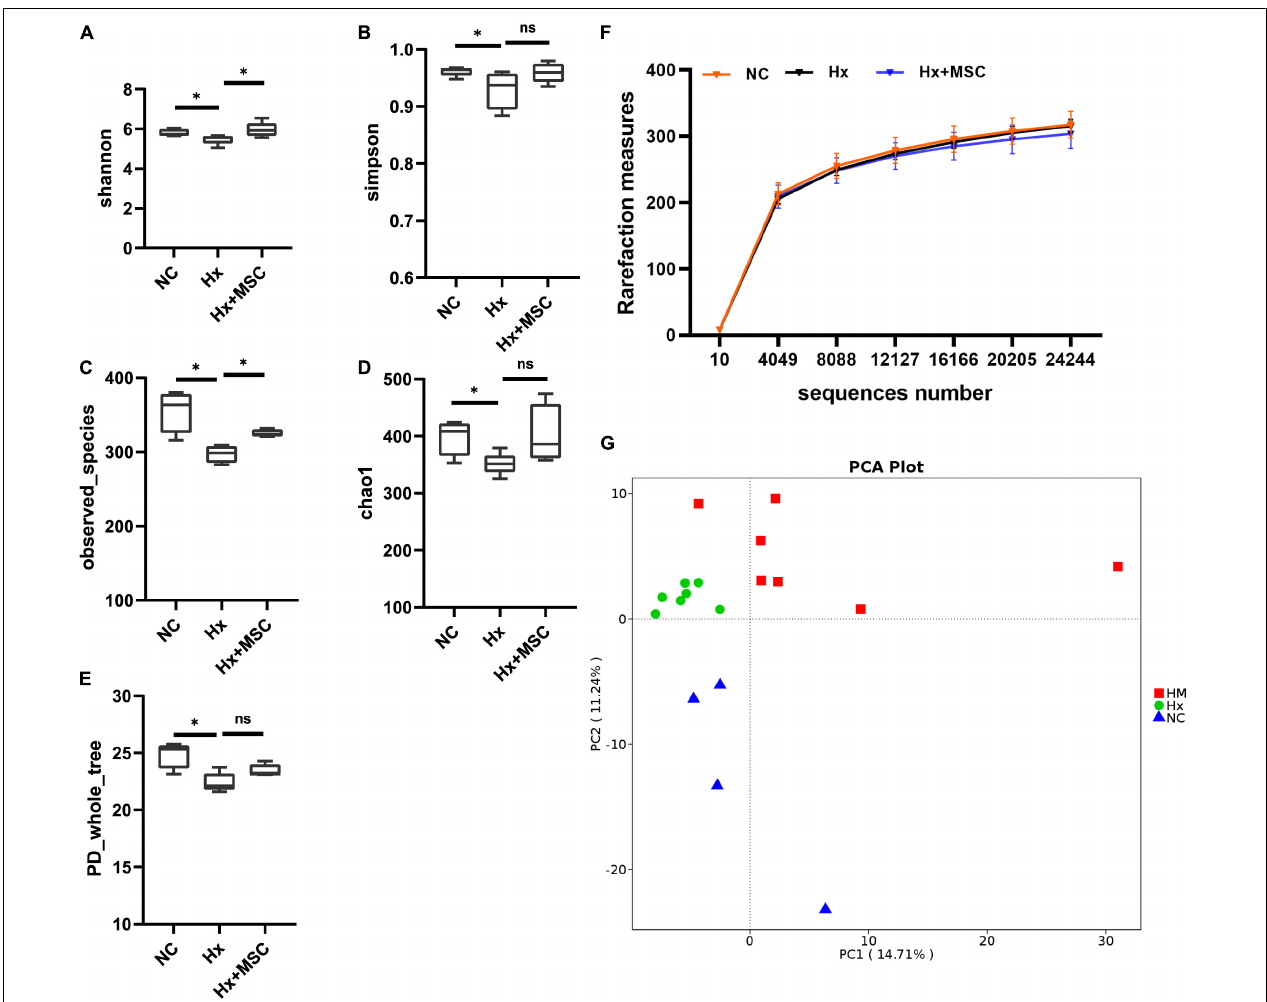
FIGURE 2 | MSC treatment reverses the gut microbiota structure in hypoxia-induced PH mice. Feces was collected from Kunming mice at 3 weeks. (A–E) The α -diversity of gut microbiota in normoxia-, hypoxia-induced and MSC-treated mice measured by the Shannon (A) , Simpsons (B) , Chao1 (C) , PD whole tree (D) , observed_species (E) indices. ∗ P < 0.05. The results are presented as means ± SEM of 4–7 animals. Chao1 estimates the number of species, whereas Shannon estimates the effective number of species. (F) Rarefaction curves for the observed species in the gut microbiota from normoxia-, hypoxia-induced, and MSC-treated mice. N = 4–7; (G) principal component analysis. NC, normoxia group; Hx, hypoxia-induced group; Hx + MSCs, MSC-treated group.